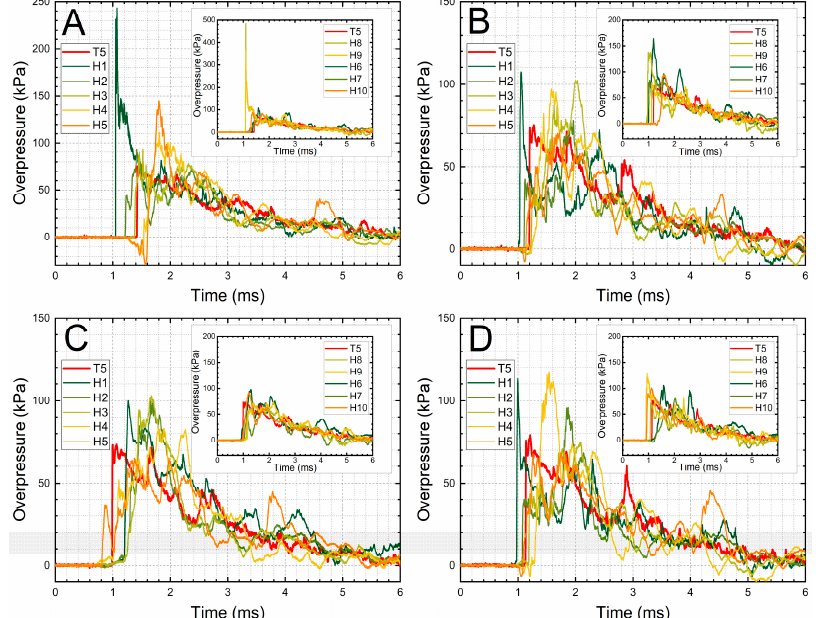
Figure 2. The representative overpressure waveforms recorded at a nominal shock wave intensity of 79 kPa (~10 psi, denoted as T5). The headform equipped with the ACH helmet was oriented at: ( A ) 0°, ( B ) 90°, ( C ) 180°, and ( D ) 270° with respect to the direction of the shock wave propagation (see diagram in Figure 1B). The data recorded by the midsagittal (H1–H5) and circumferential (H6–H10, insets) sensors embedded in the headform are presented.